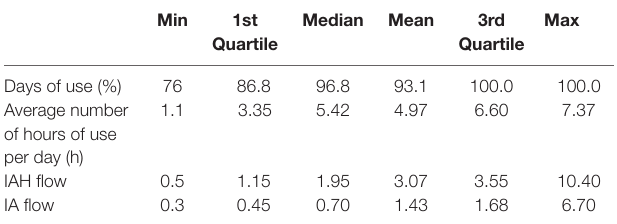
TaBle 5 | Statistical Characterization of the continuous positive airway pressure adherence.